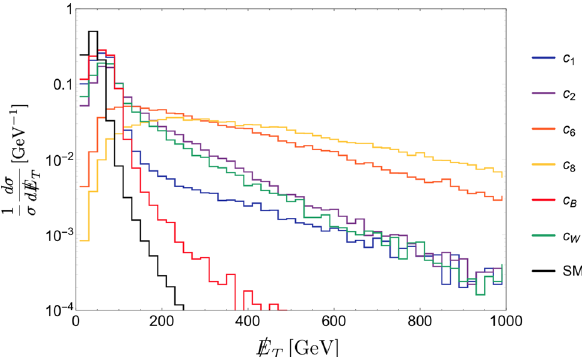
Fig. 8 Missing transverse energy distributions for pp → aW ± γ √ s = 13TeV LHC normalised to unity, for signals ( W ± → (cid:17) ± ν ) at generated one by one for operators A 1 ( blue ), A 2 ( violet ), A 6 ( orange ), A A ˜ ( green ) and A ˜ ( red ) 8 ( yellow ), W B